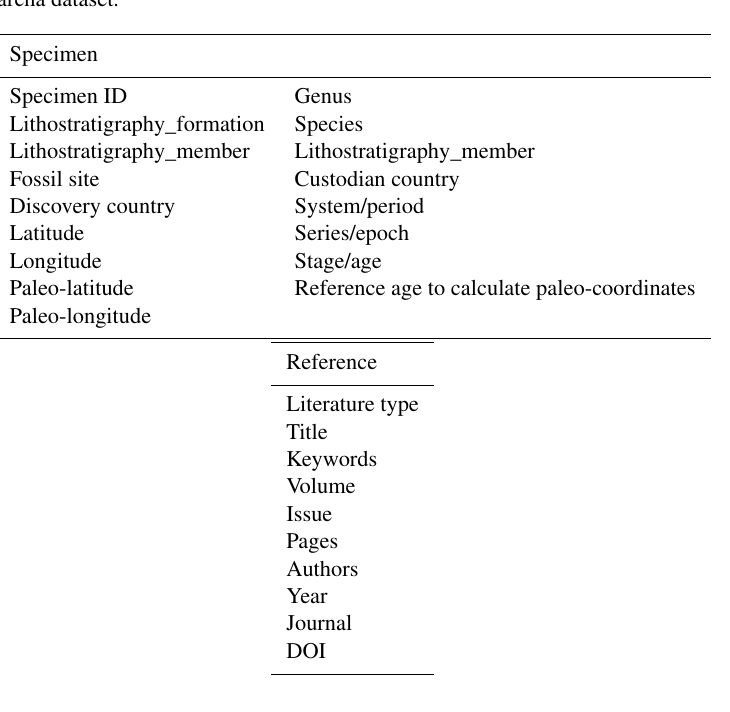
Figure 4. Antiarch placoderm spatial distribution. The tree topology is simplified from the phylogenetic result in Pan et al. (2018). Numbers under the pie chart represent each group’s relative amounts of specimens. Terminal groups are linked with their geographic distributions. Each node represents a single specimen. Specimens from one locality overlap each other. Table 1. The structure of Antiarcha